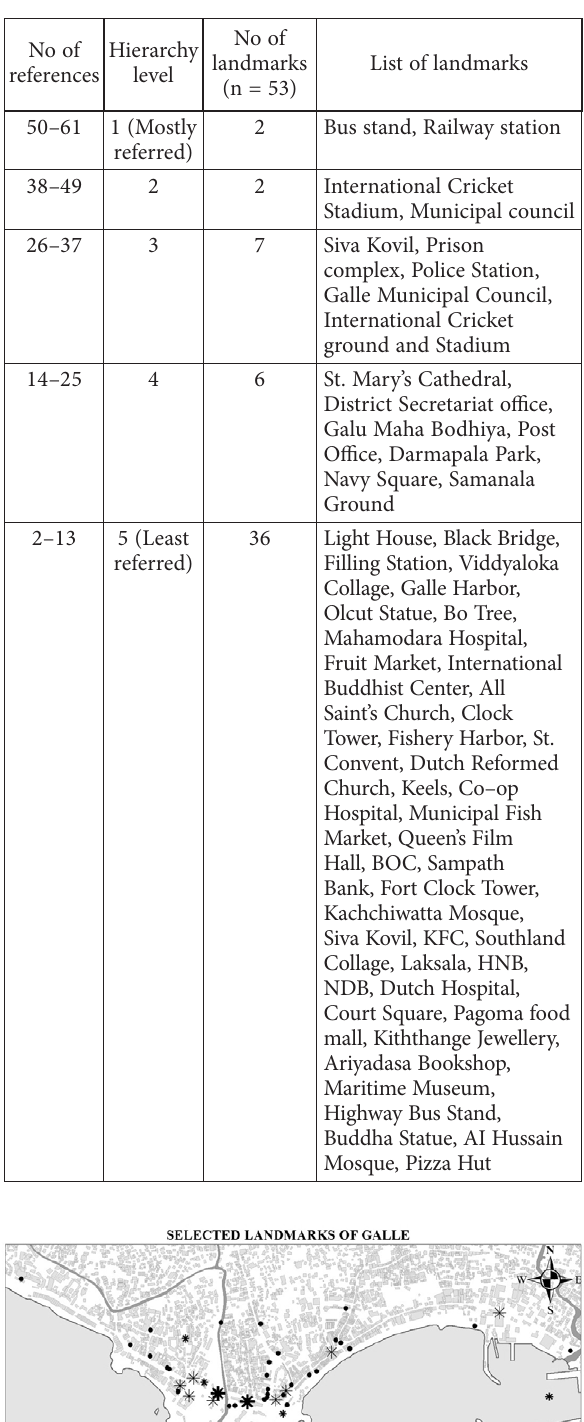
Table 1. Classification of landmarks